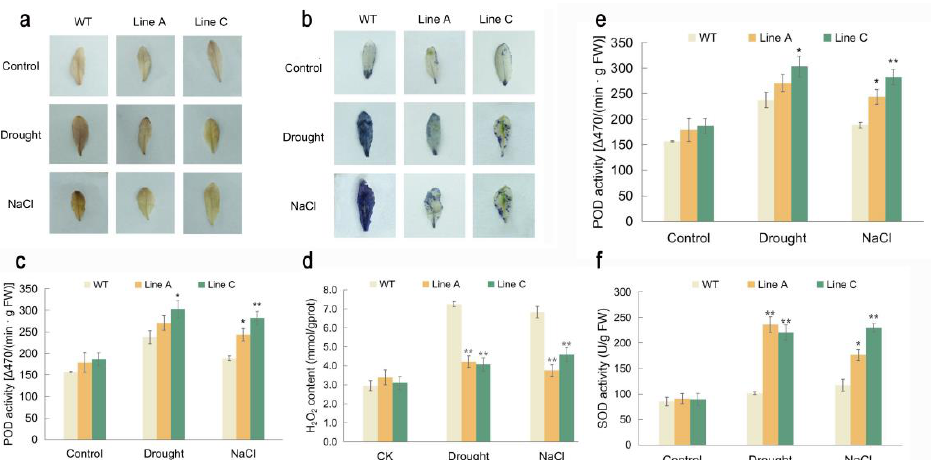
Figure 5. Analysis of ROS accumulation and activities of key antioxidant enzymes under drought and salt treatments. ( a , b ) showed the analysis of H 2 O 2 and O 2 − accumulation by using histochemical staining with DAB and NBT, respectively. ( c , d ) showed the content of hydrogen peroxide (H 2 O 2 ) and superoxide anion content (O 2 − ), respectively. ( e , f ) indicated activities of peroxidase (POD) and superoxide dismutase (SOD) in the leaves of transgenic and WT plants, respectively. Data are presented as mean and SD values of three independent experiments. Asterisks indicated significant difference (* p < 0.05, ** p < 0.01, by independent sample t -test) compared to WT.